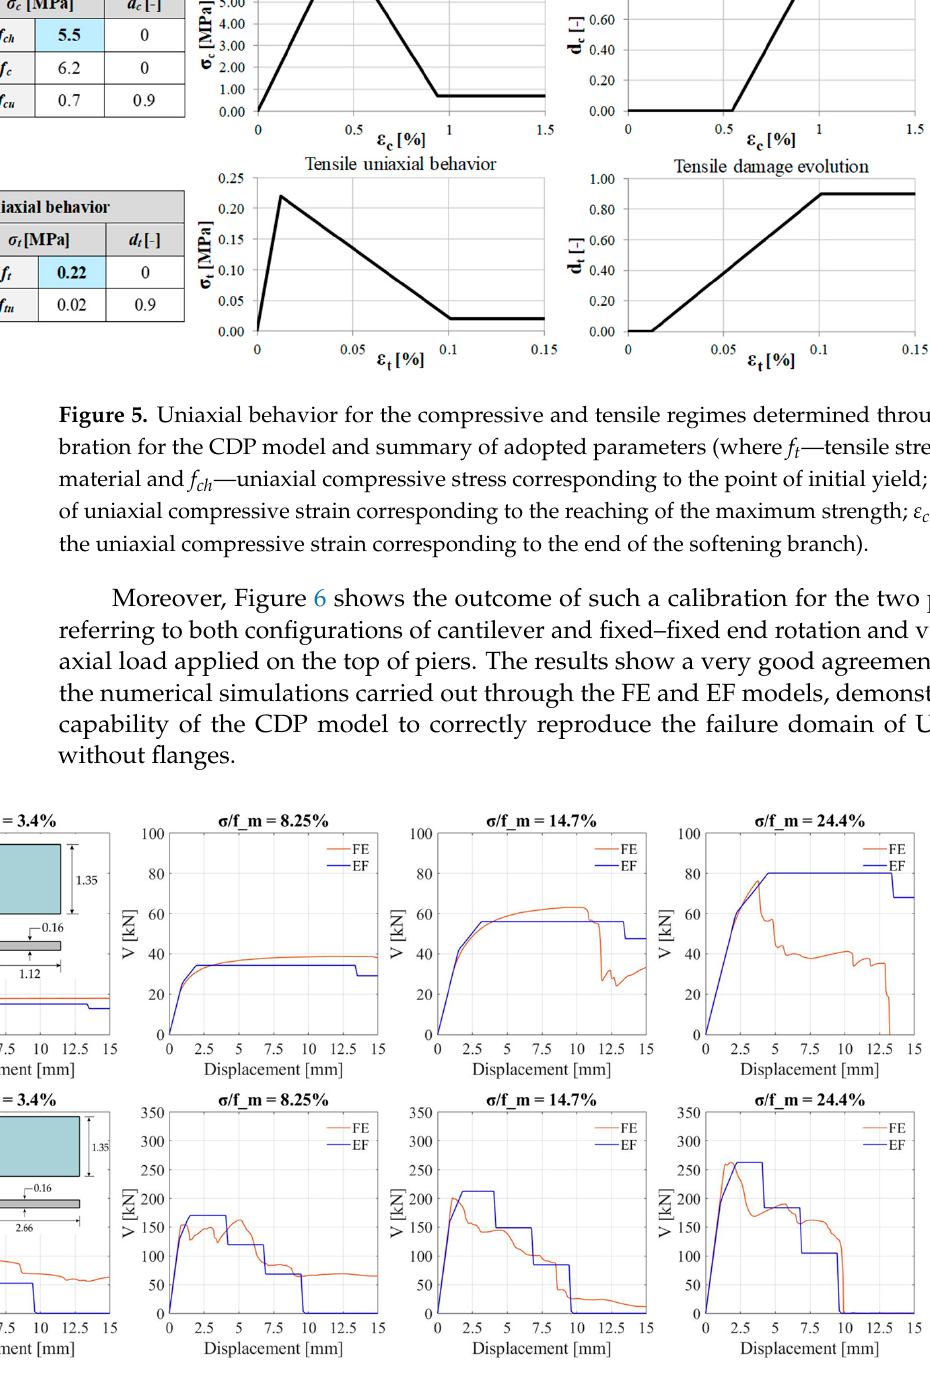
Figure 6. Comparison of the base shear-displacement curves of masonry piers adopted for the calibration process varying the acting compressive stress state.